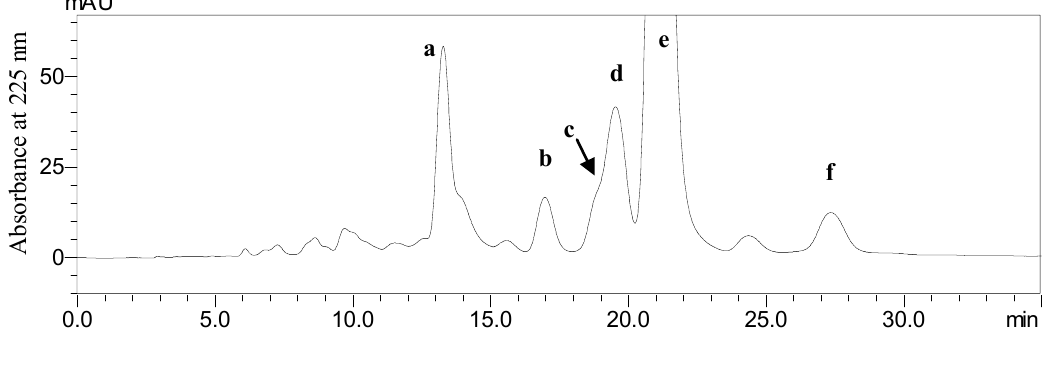
Figure 1. HPLC chromatogram of the ethyl acetate crude extract from endophytic fungus Berkleasmium sp. Dzf12. The retention times of peaks a–f were 13.28, 16.97, 18.54, 19.63, 21.13 and 27.34 min, respectively.